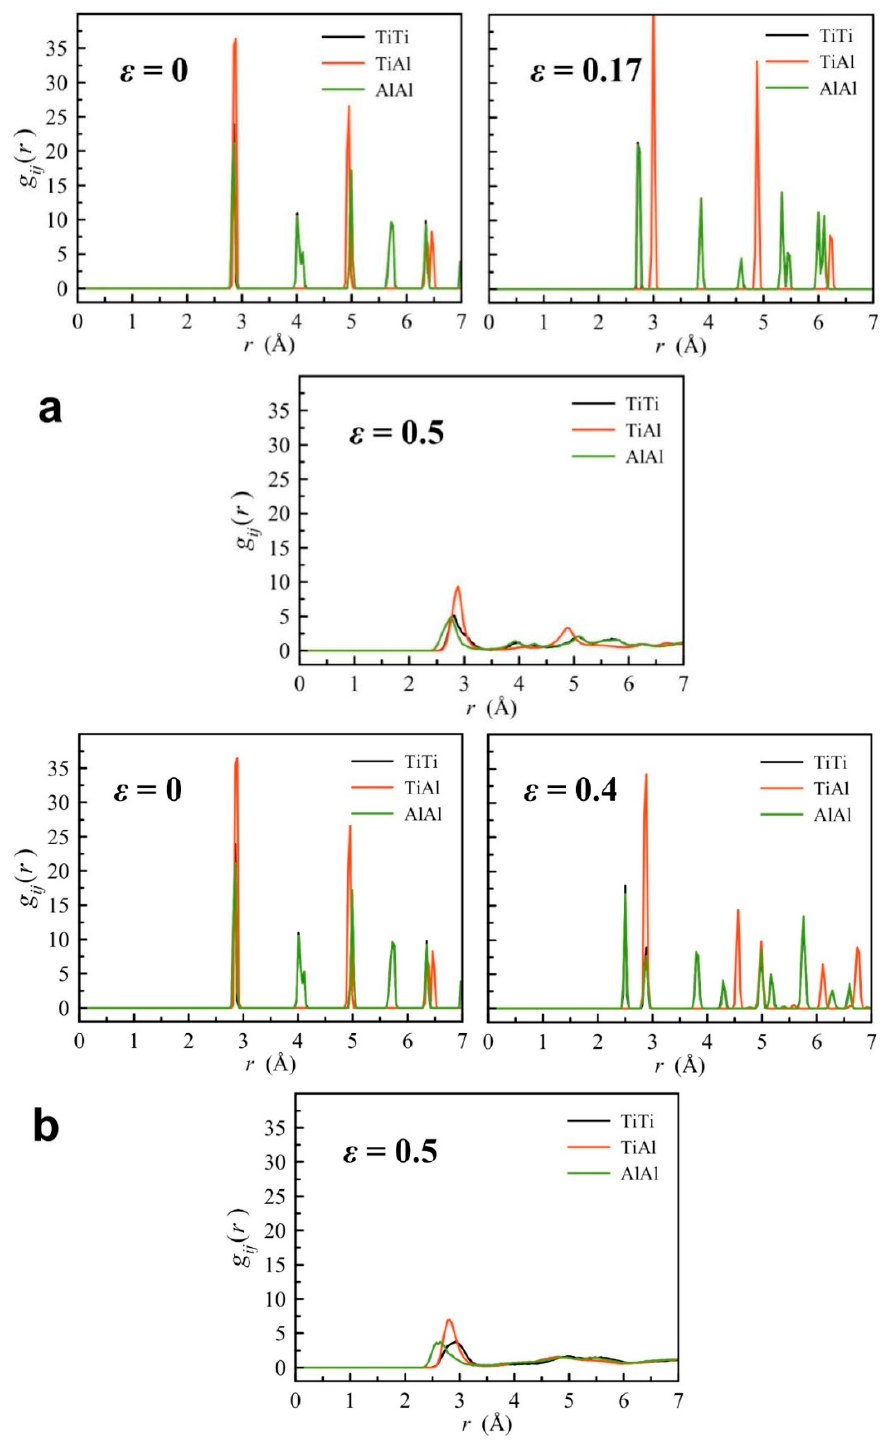
Figure 10. Partial radial distribution function g ij for uniaxial ( a ) tensile and ( b ) compressive loading of TiAl alloy in the <001> direction. The black, red, and green lines represent the TiTi, TiAl, and AlAl pairs, respectively.